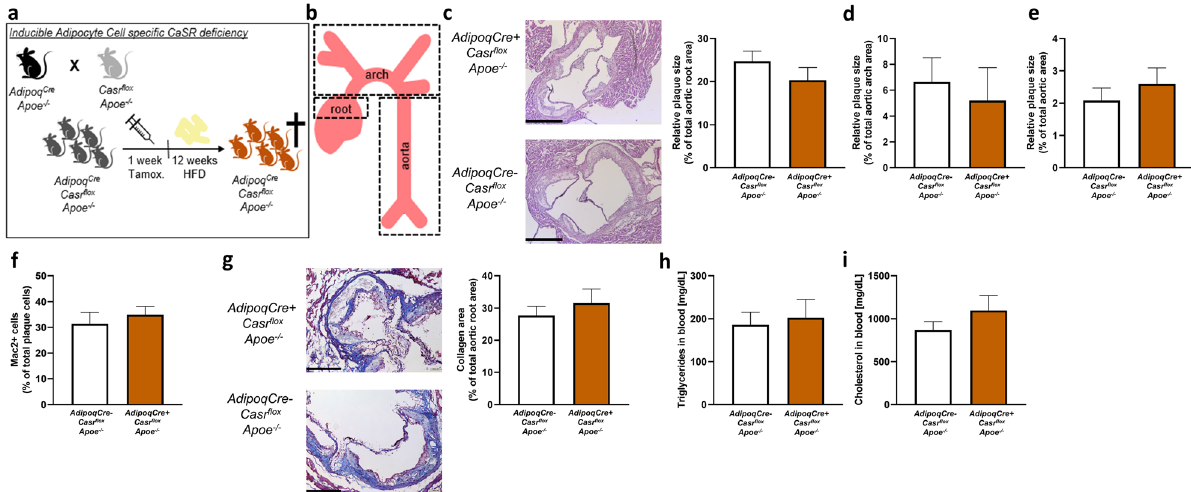
Figure 2. Adipocyte specific CaSR deficiency does not influence advanced stages of atherosclerosis. ( a ) Representation of the experimental workflow. Mice were crossed and offspring were injected with tamoxifen and fed a HFD for 12 weeks before analysis. ( b ) Schematic representation of the areas that were used for analysing atherosclerotic plaques. ( c ) Representative images and quantification of aortic root lesions in both AdipoqCre− Casr flox Apoe −/− and AdipoqCre + Casr flox Apoe −/− mice (n = 9–10). Scale bar 500 µm. ( d , e ) Quantification of aortic arch lesions (n = 5) ( d ) and thoraco-abdominal aortic lesions (n = 9–10) ( e ) in AdipoqCre− Casr flox Apoe −/− and AdipoqCre + Casr flox Apoe −/− mice. ( f ) Quantification of macrophage content of aortic root lesions in AdipoqCre− Casr flox Apoe −/− and AdipoqCre + Casr flox Apoe −/− mice (n = 9). ( g ) Images to represent the presence of collagen in plaques in aortic roots and their quantification in AdipoqCre− Casr flox Apoe −/− and AdipoqCre + Casr flox Apoe −/− mice (n = 10). Scale bar 250 µm. ( h , i ) Quantification of plasma triglycerides ( h ) and cholesterol ( i ) levels of AdipoqCre− Casr flox Apoe −/− and AdipoqCre + Casr flox Apoe −/− mice (n = 10–11). Image processing was done using Image J 1.53 (https:// imagej. nih. gov/ ij/). Bar graphs are representation of mean ±